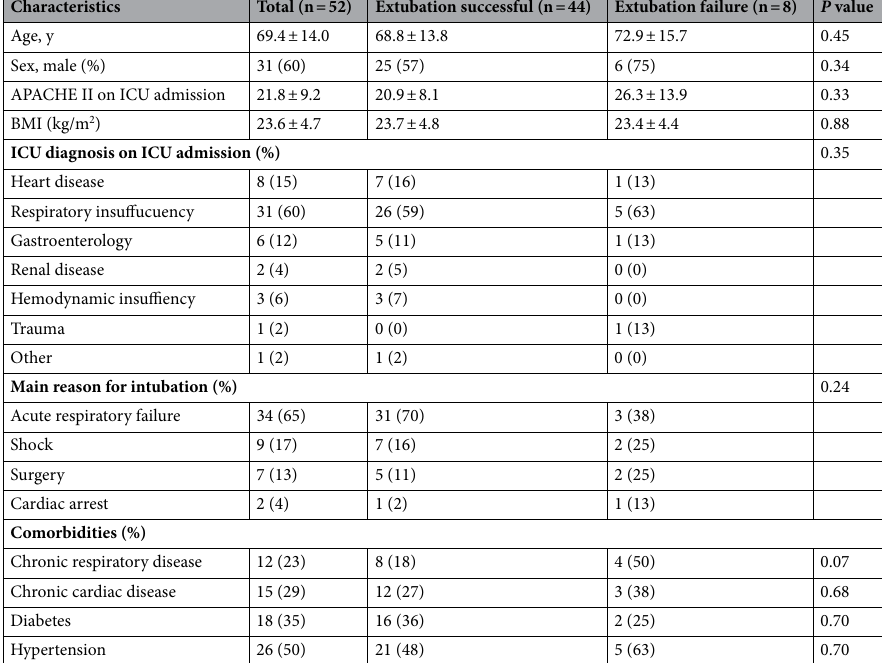
Table 1. Characteristics of the patients at admission. APACHE II acute physiology and chronic health evaluation II, BMI body mass index, ICU intensive care